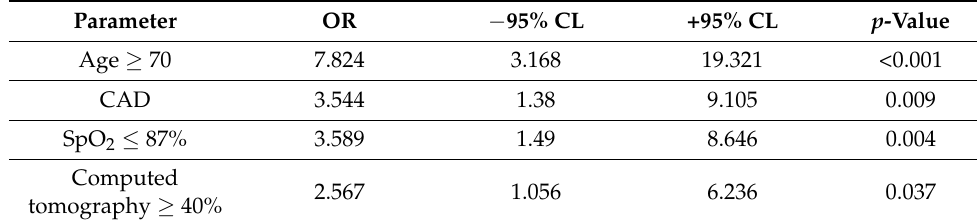
Table 5. Multivariate predictors of in-hospital mortality of patients with COVID-19.